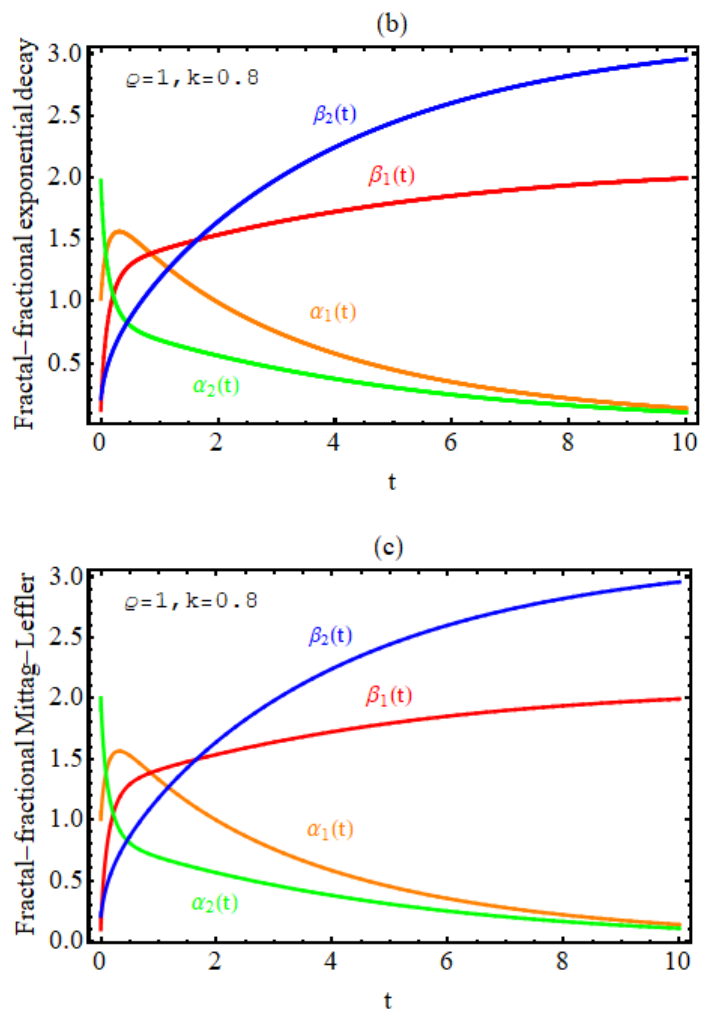
Figure 3. The numerical solutions of the fractal–fractional Michaelis–Menten enzymatic reaction for (cid:36) = 1, k = 0.8, δ = 1, γ = 2, σ = 1, and h = 0.003. ( a ) The numerical solutions of Equations (36)–(39) based on power-law kernel; ( b ) The numerical solutions of Equations (62)–(65) based on exponential decay kernel; ( c ) The numerical solutions of Equations (82)–(85) based on Mittag-Leffler kernel (orange line: α 1 ( t ) ; red line: β 1 ( t ) ; green color: α 2 ( t ) ; blue line: β 2 ( t )) .